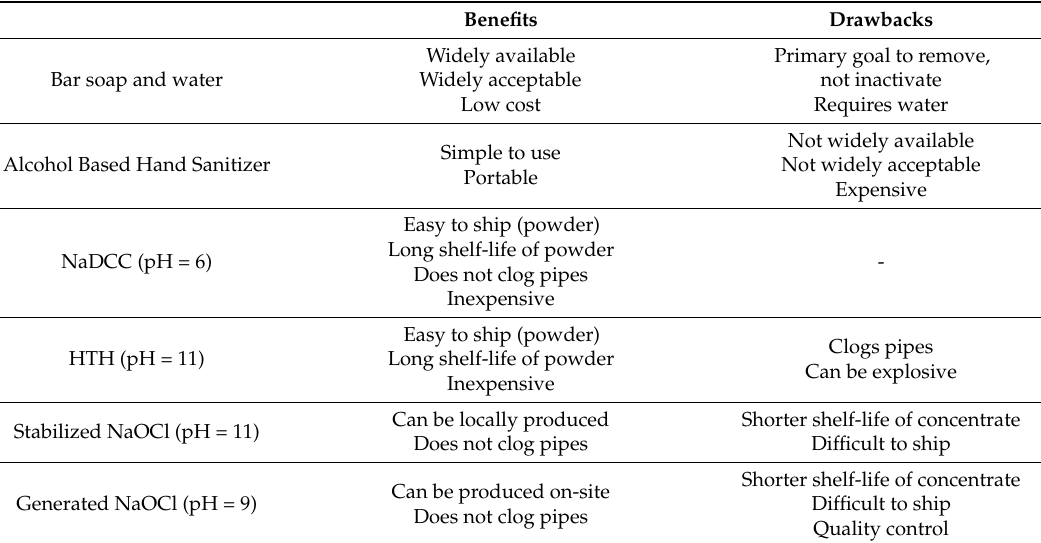
Table 2. Benefits and Drawbacks of Disinfectants Used for Surfaces and Hands. Benefits Drawbacks Bar soap and